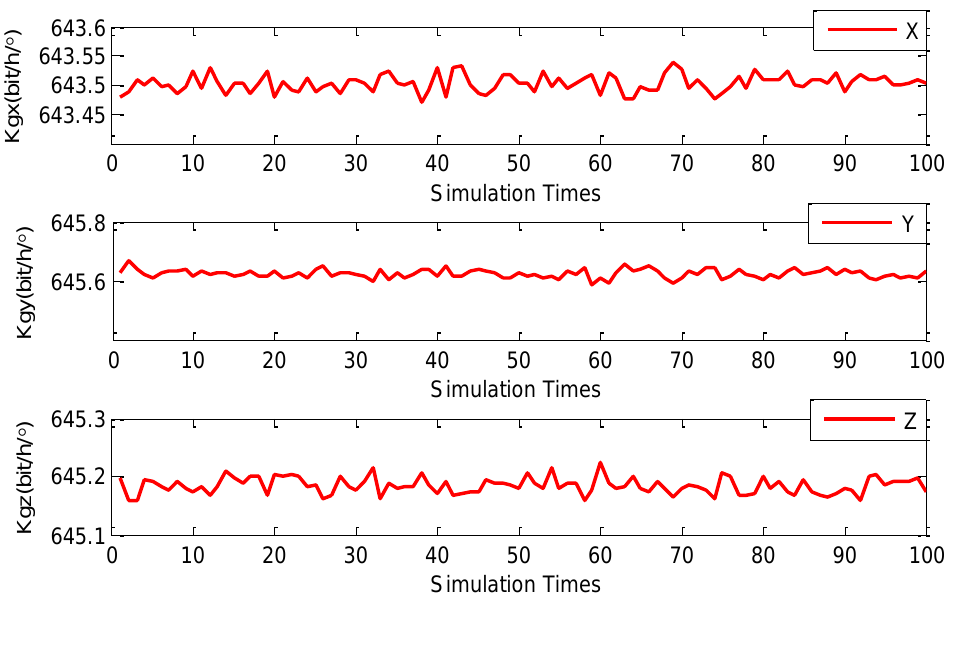
Figure 1. FOG scale factors MCS-NAFSA curves.